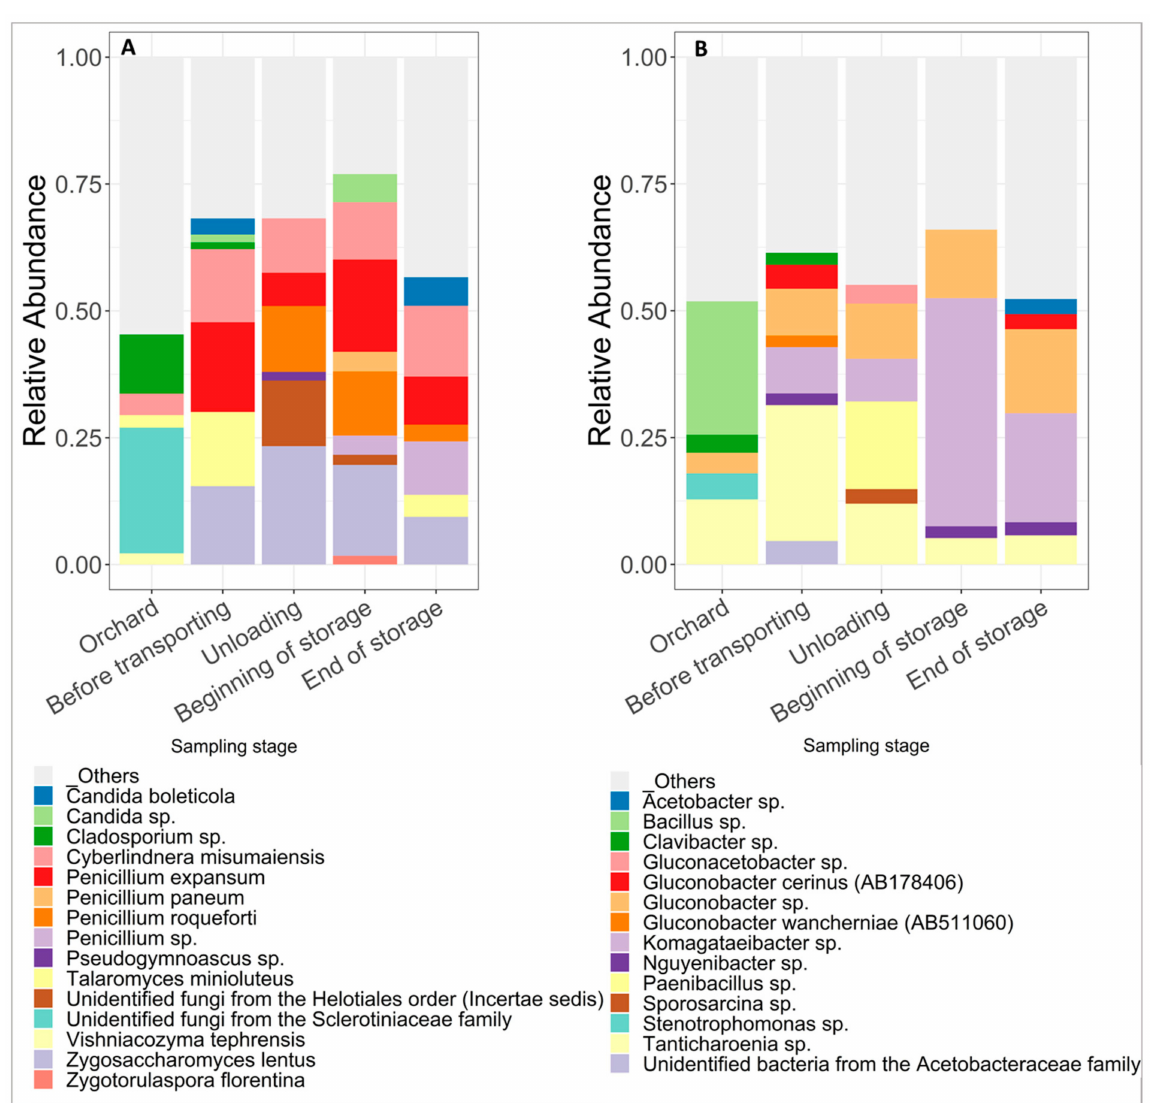
Figure 7. Relative abundance of fungal ( A ) and bacterial ( B ) top 10 species detected at the surface of cider-apples picked at different post-harvest sampling steps. Fungal and bacterial species with less than 0.5% are reported as “others”. When the taxonomic identification wasn’t possible to the species level, the ASV was identified by the lowest possible level of the phylogenetic